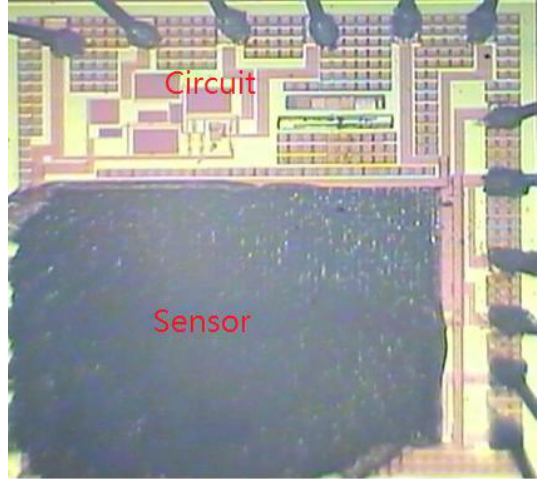
Figure 9. Optical image of the integrated humidity sensor after the